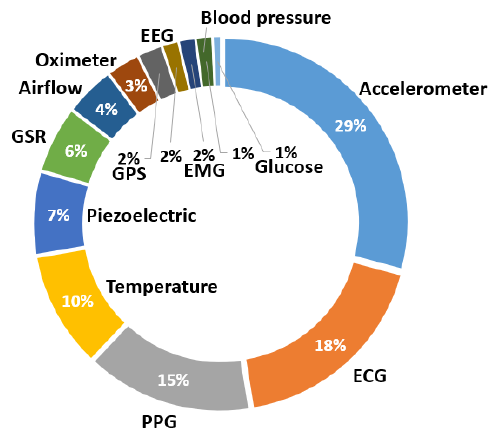
Figure 16. Distribution of sensors used in published